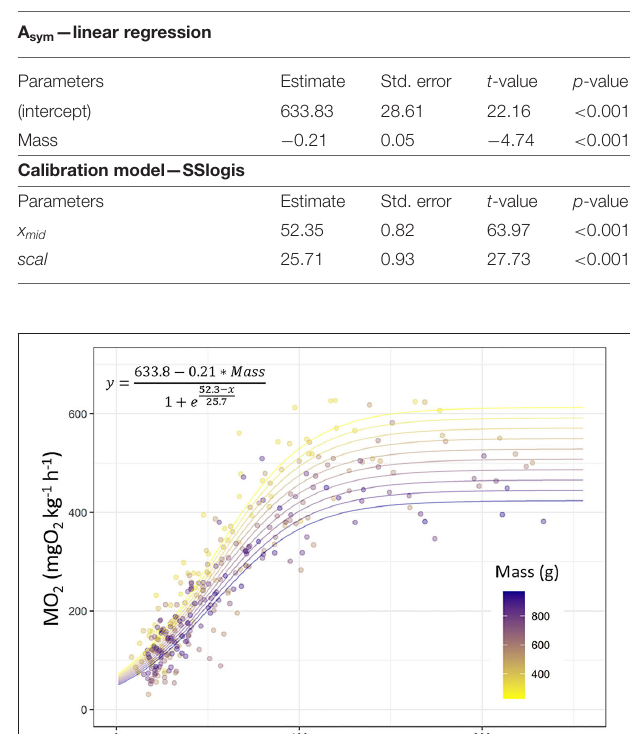
fish for health or welfare monitoring of the whole